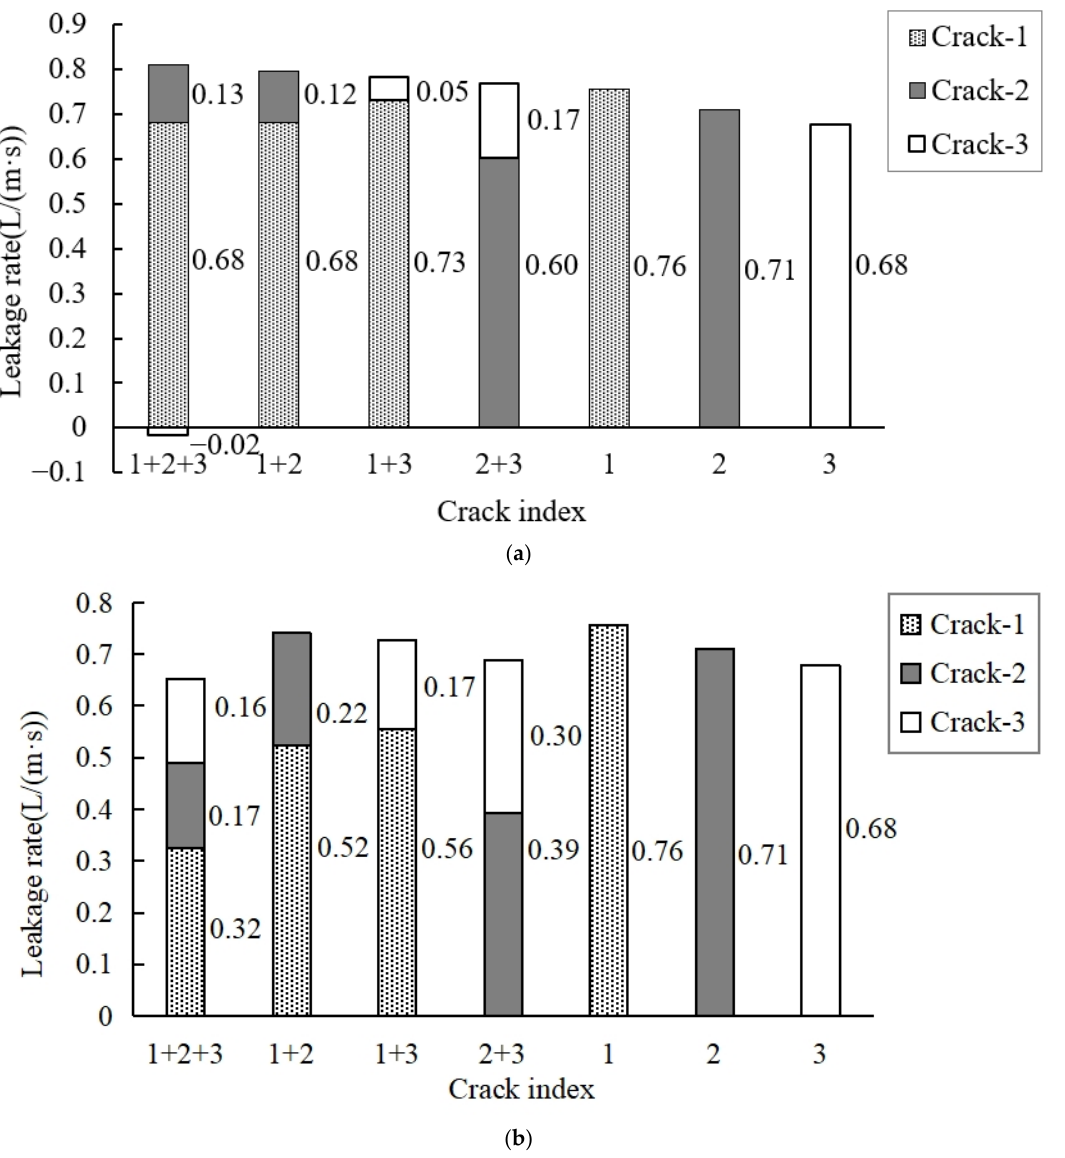
Figure 11. Leaked-air rate when different cracks were in use: ( a ) each crack with a width of 2.66 mm; ( b ) the total width of all cracks equaled 2.66 mm.